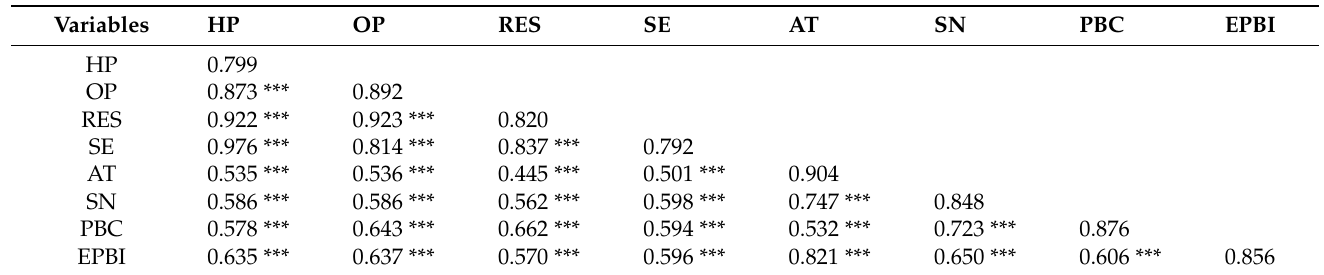
Table 4. Analysis of discriminant validity of the scale.